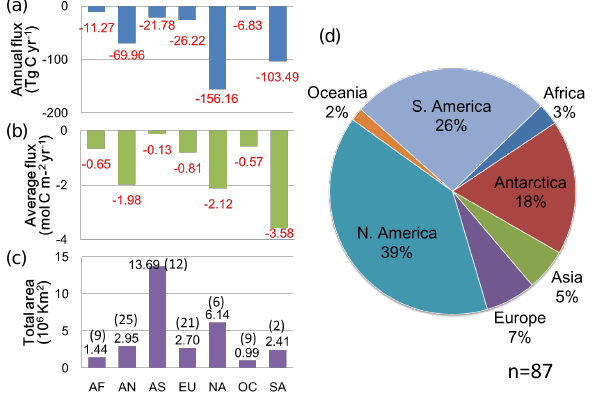
1 Figure 12. Annual CO 2 flux (a), average CO 2 flux per unit area (b), total surface area (c), and percentage of 2 Fig. 12. Annual CO 2 flux (a) , average CO 2 flux per unit area (b) , total CO 2 flux (d) from continental shelves in different oceans.. Numbers in parentheses indicate 3 total surface area (c) , and percentage of total CO 2 flux (d) from the number of estuaries studied. 4 continental shelves in different oceans. Numbers in parentheses in- 5 dicate the number of estuaries